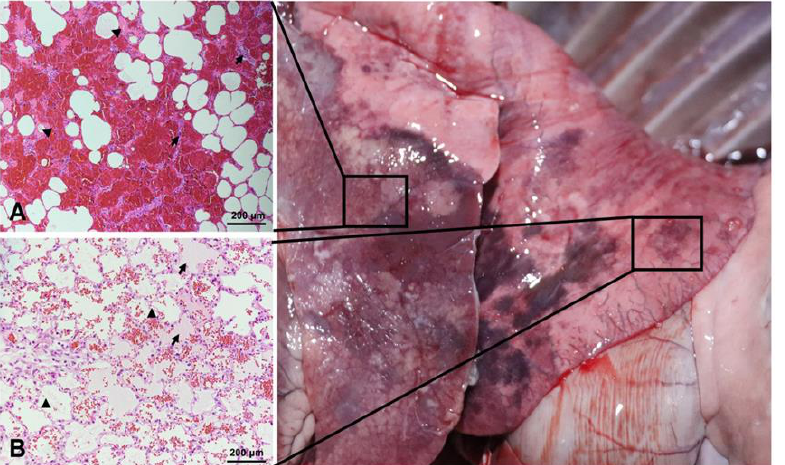
Figure 2. HE -stained pathological sections of different parts of the lungs from the sheep. ( A ) Infil- trating lymphocytes (black arrow): the alveolar space of the lung tissue was thickened, and the in- terstitial lung was congested (black triangle) (bar = 200 µm, 200×); ( B ) fibrinous exudation (black arrow): vacuoles were visible in the alveolar cells (black triangle) (bar = 200 µm, 200×). A lung sample was used for testing for common respiratory pathogens such as My- coplasma [14], peste des petits ruminant’s virus (PPRV) [15], foot and mouth disease virus (FMDV) [15], Maedi-Visna (MV) [16], parainfluenza virus type 3 (PIV3) [17], and ovine respiratory syncytial virus (ORSV) [18] using previously reported methods (primer sequences are available in Table S2), and the results were negative. At the same time, small pieces of lungs were used for pathogenic bacterial isolation. Specifically, inoculation on nutrient agar containing 5% sheep blood was performed using a sterilized inoculation loop dipped in the fresh-cut surface of the lung. After anaerobic and aerobic incubation at 37 ◦ C for 24 h, single-strain isolates were subjected to three rounds of single colony purification. A bacterium strain was isolated in the lung, which is a gram-negative, rod-shaped strain with β -hemolytic, shown in Figure 3.